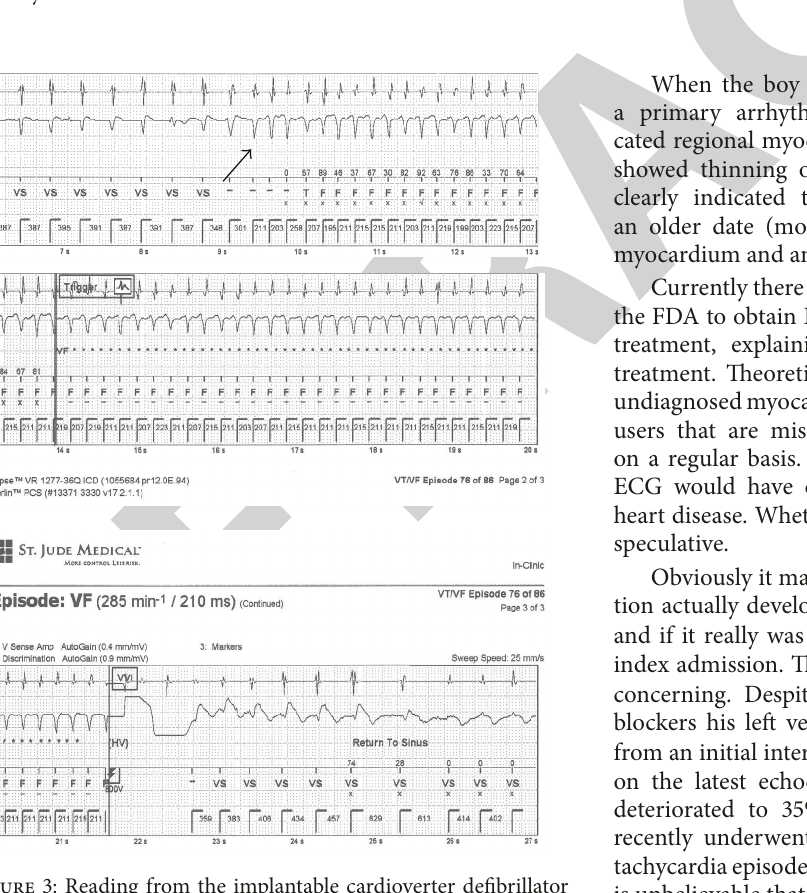
Figure 2: Cardiac magnetic resonance (CMR) imaging showing short-axis views in diastole (a) by cine CMR and (b) by late gadolinium enhancement imaging. Arrows indicate myocardial wall thinning and late gadolinium enhancement in the circumflex artery area consistent with myocardial necrosis and scar formation.